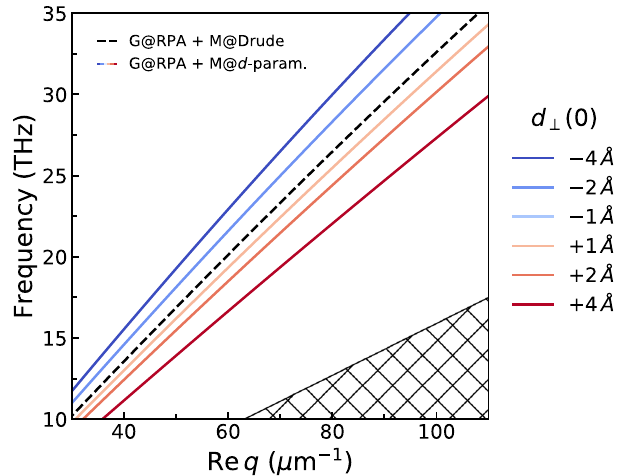
Fig. 3 Concept for using the spectral shifting of AGPs for retrieving the quantum surface-response of metals. Impact of d ⊥ ( ω ≪ ω p ) ≃ d ≡ ζ on the AGP ’ s dispersion [obtained through the numerical ⊥ (0) solution of Eq. (1)]. All parameters (with the exception of d ⊥ ) are the same as in Fig.